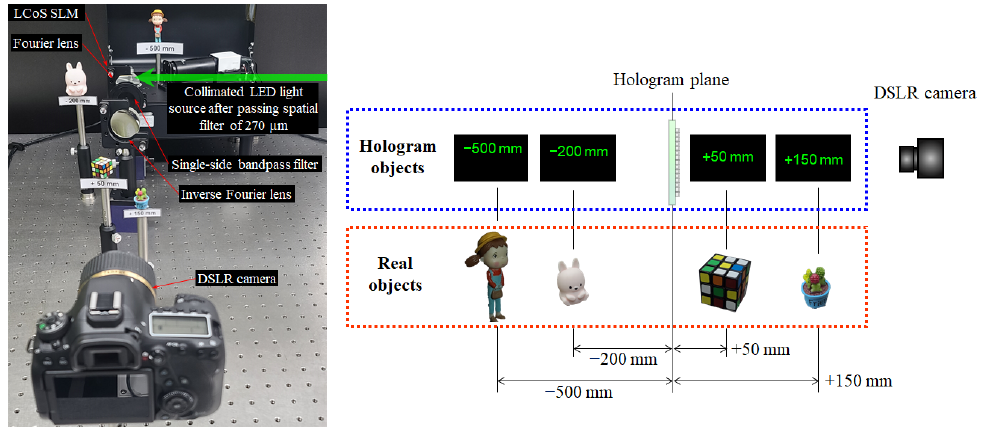
Figure 12. Experimental setup of reconstructing holographic image based on the LED light source with a spatial filter size of 270 µm.